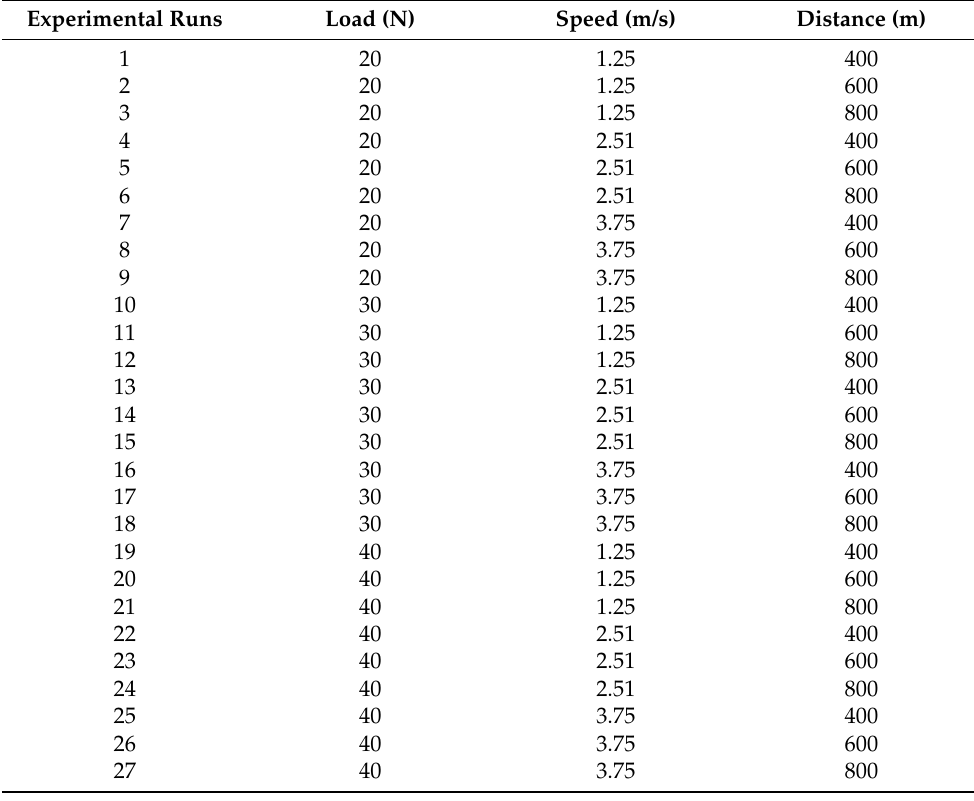
Table 3. Design of Experiment (DOE)